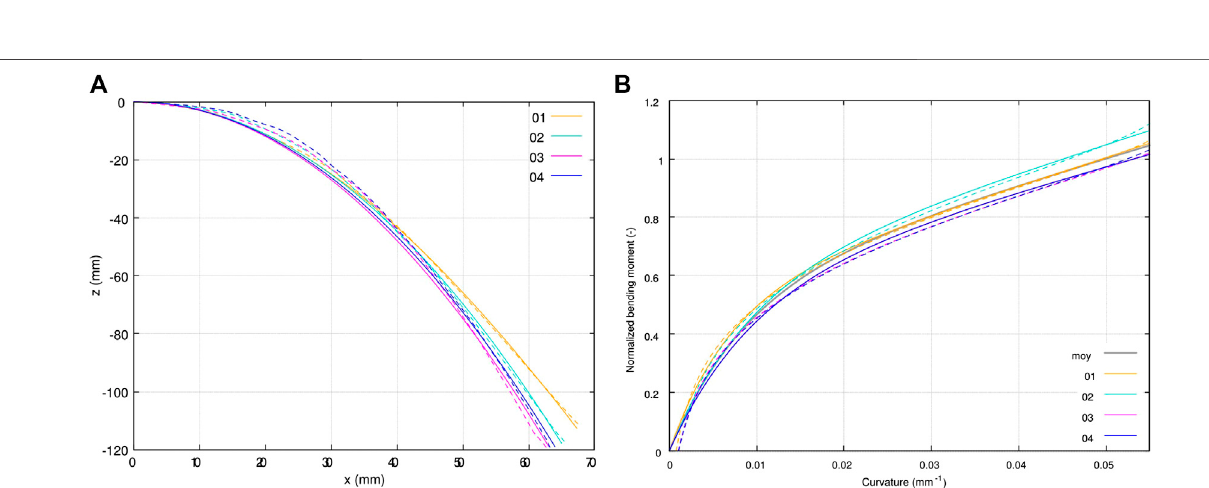
FIGURE 9 | Results of bending tests on single plies at room temperature using three different lumped masses m 4 , m 6 and m 7 such that m 7 > m 6 > m 4 : (A) experimental data of the deformed sample mean line and (B) normalized bending moment – curvature relationship using Voce ’ s model. Each curve corresponds to one single test.